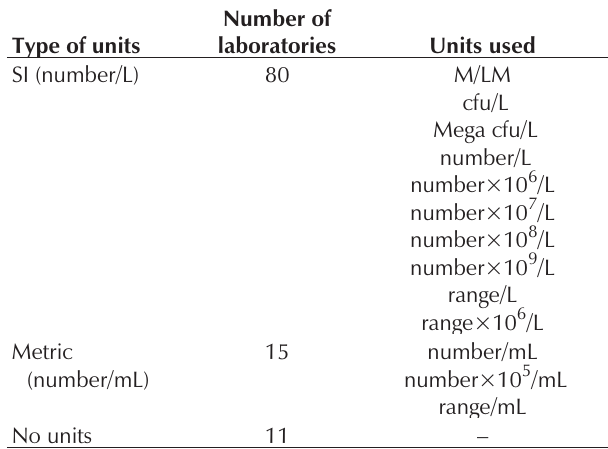
Units used to express colony